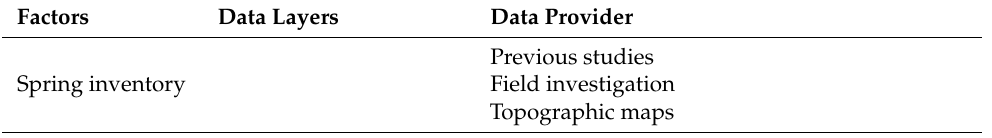
Table 1. Spatial database of the study